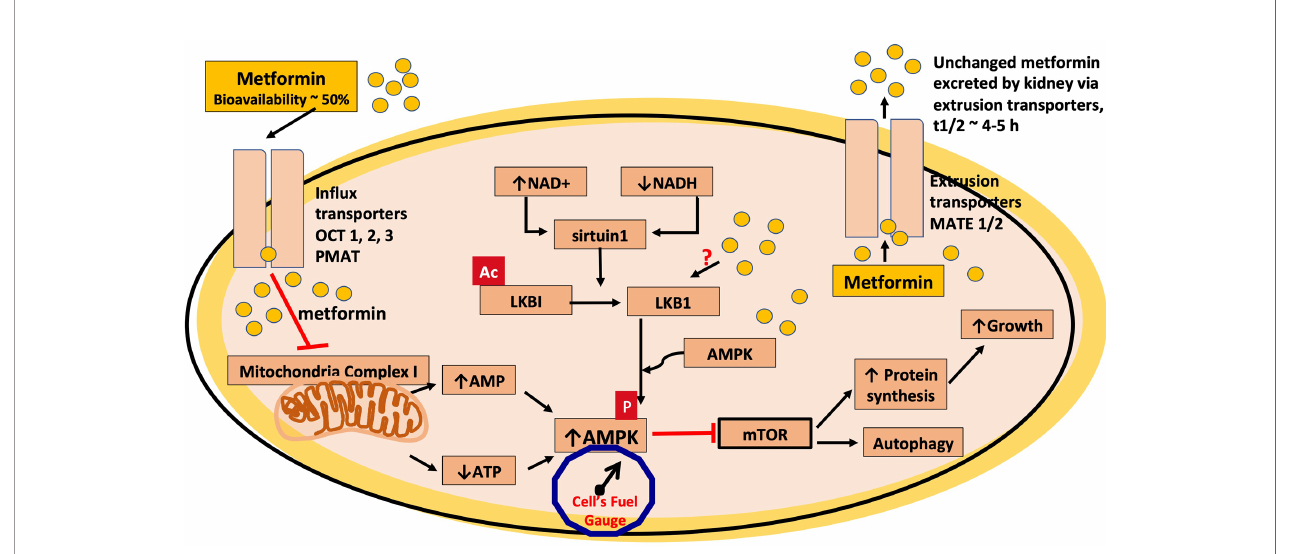
FIGURE 1 | Metformin inhibits mitochondrial complex 1. In this schematic, metformin is transported into the cell via the organic cation transporters, OCT 1, 2 and 3 and the plasma membrane monoamine transporter (PMAT). The transport of metformin out of the cell is mediated through the multidrug and toxin extrusion (MATE1/ 2) transporters. Metformin is thought to mediate most of its cellular effects via activation of AMPK and, in this schematic, metformin inhibits the electron transport chain of mitochondrial complex 1, which leads to a reduction in ATP levels, increasing the AMP/ATP ratio, thus increasing AMPK activation and also reduces the generation of reactive oxygen species (ROS). AMPK activation leads to an inhibition of the mTOR pathway, which would contribute to the antitumor effects of metformin. Metformin also has been shown to activate AMPK via the serine-threonine liver kinase B1 (LKB1) where phosphorylation (p) (activation) of AMPK occurs. The protein product of SIRT1, sirtuin1, is an upstream deacetylase, which activates LKB1 via deacetylation as indicated in the fi gure by loss of ac, at times of cellular stress and decreased cellular energy, when NAD+/NADH ratio is high and is also a putative site of action for